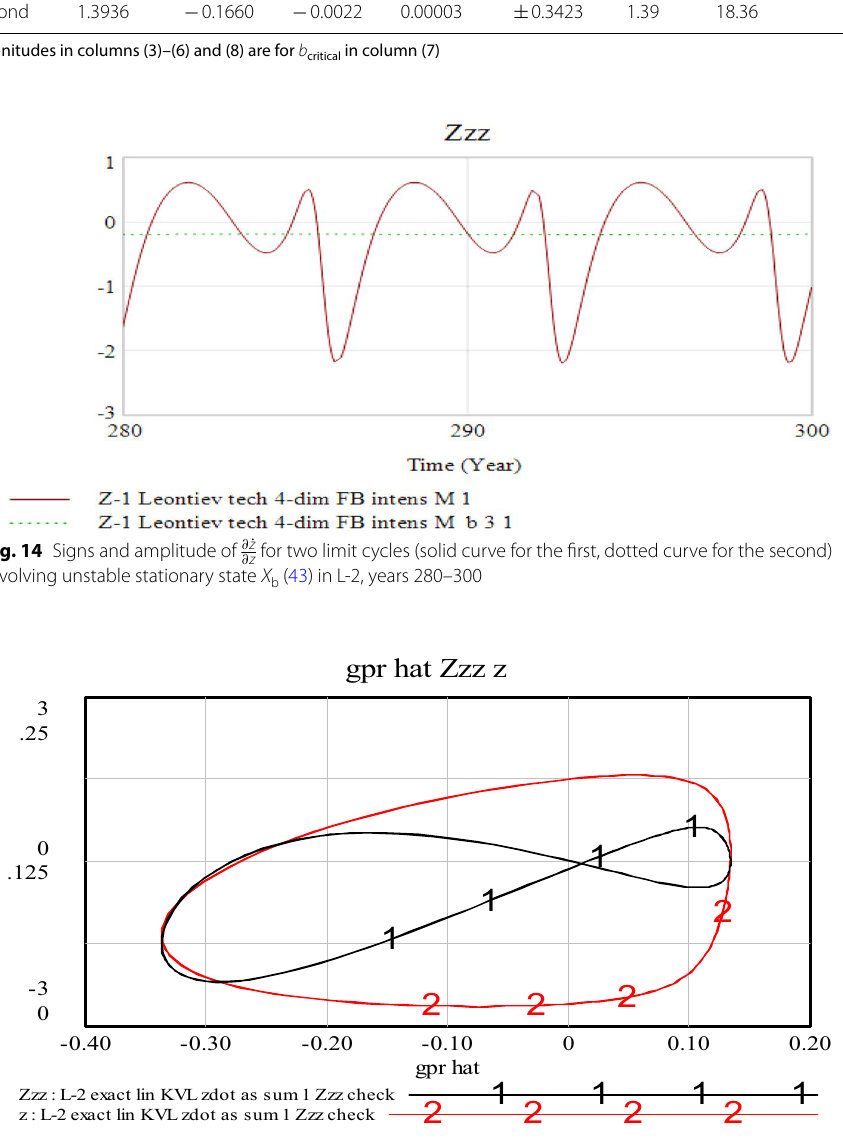
Magnitudes in columns (3)–(6) and (8) are for b critical in column (7)